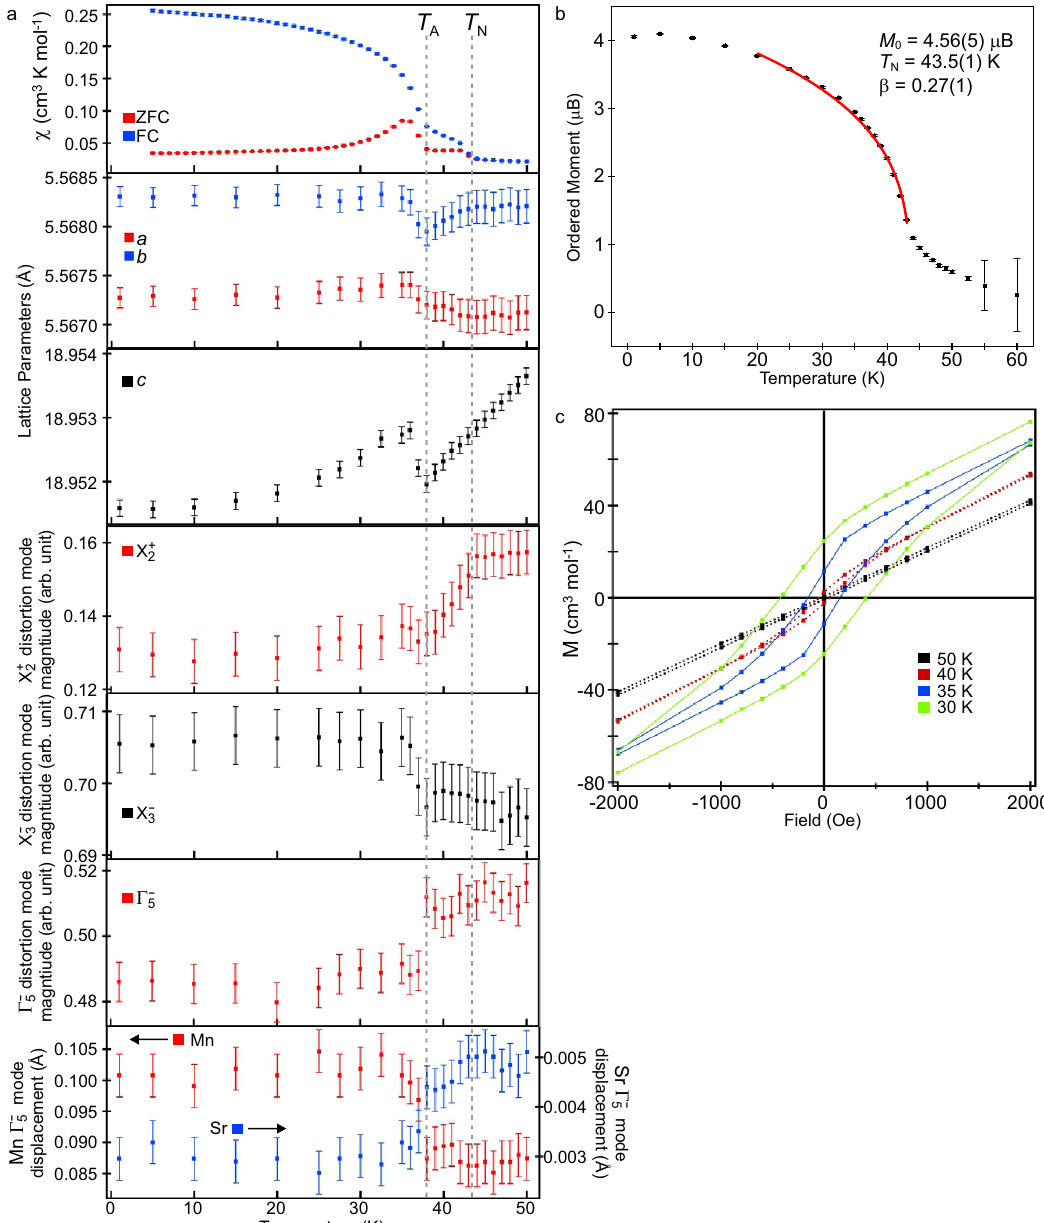
Fig. 4 Evidence for magnetoelectric coupling in MnSrTa 2 O 7 . a Zero- fi eld-cooled and fi eld-cooled magnetisation data, lattice parameters, X 2 + , X 3 – , and Γ 5 – distortion-mode magnitude (arbitrary units) 45, 46 and Mn and Sr Γ 5 – mode displacement of MnSrTa 2 O 7 in the temperature range 0 < T /K < 50. b (cid:3) β M ¼ M 1 (cid:2) T T power law fi t to ordered Mn moment (obtained by NPD data) as a function of temperature. c Expanded region around H = 0 of 0 N magnetisation- fi eld data collected from MnSrTa 2 O 7 in an applied fi eld in the range − 50000< H /Oe <